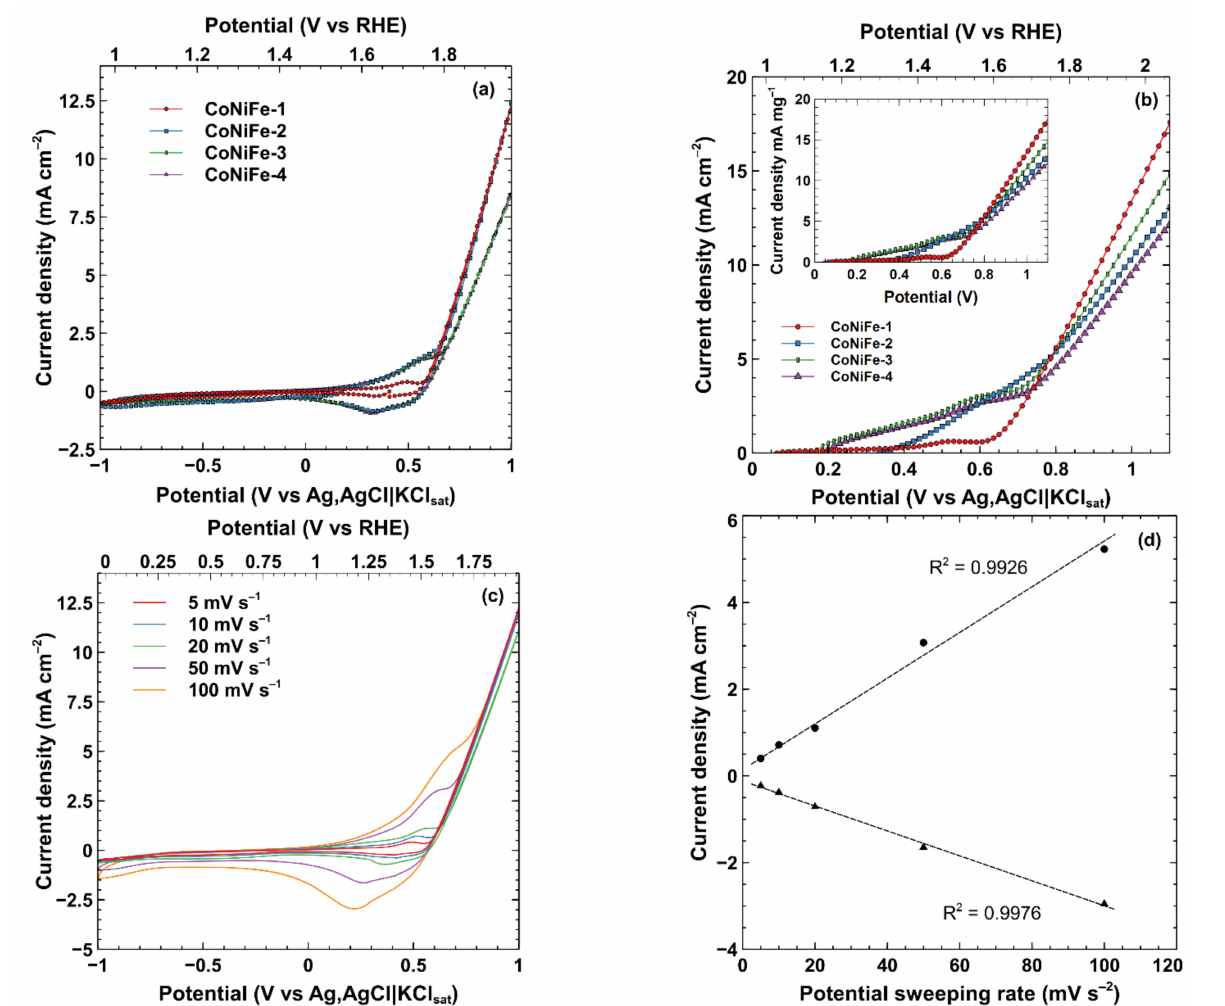
Figure 4. ( a ) Cyclic voltammograms of cobalt-nickel-iron oxides in 0.1 M NaOH at 5 mV s − 1 potential sweeping rate. ( b ) Linear sweep voltammograms of cobalt-nickel-iron oxides in 0.1 M NaOH at 20 mV s − 1 potential sweeping rate. Inset: linear sweep voltammograms of cobalt-nickel-iron oxides in 0.1 M NaOH normalized by mass. ( c ) Cyclic voltammograms of CoNiFe-1 sample in 0.1 M NaOH at different scan rates. ( d ) The dependency of anodic and cathodic peak (in the range of 0.2–0.6 V) currents on the potential sweep rate of CoNiFe-1